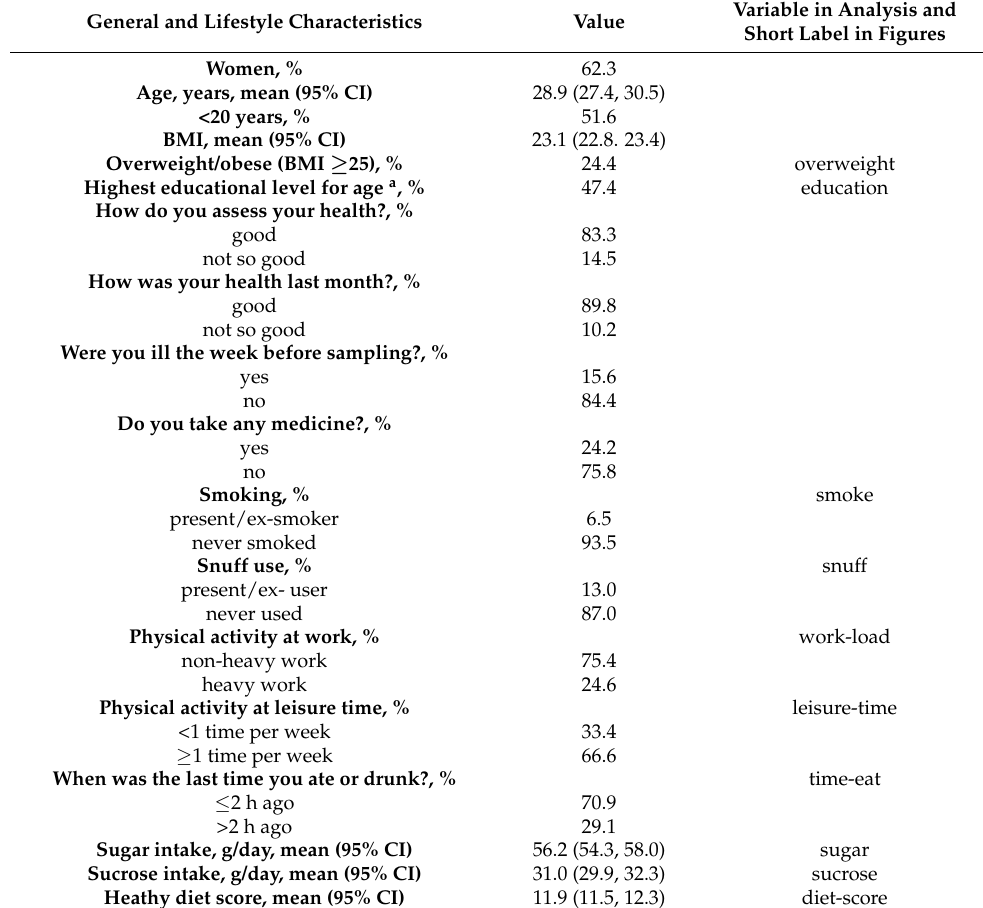
Table 1. General and lifestyle characteristics of the participants in the study